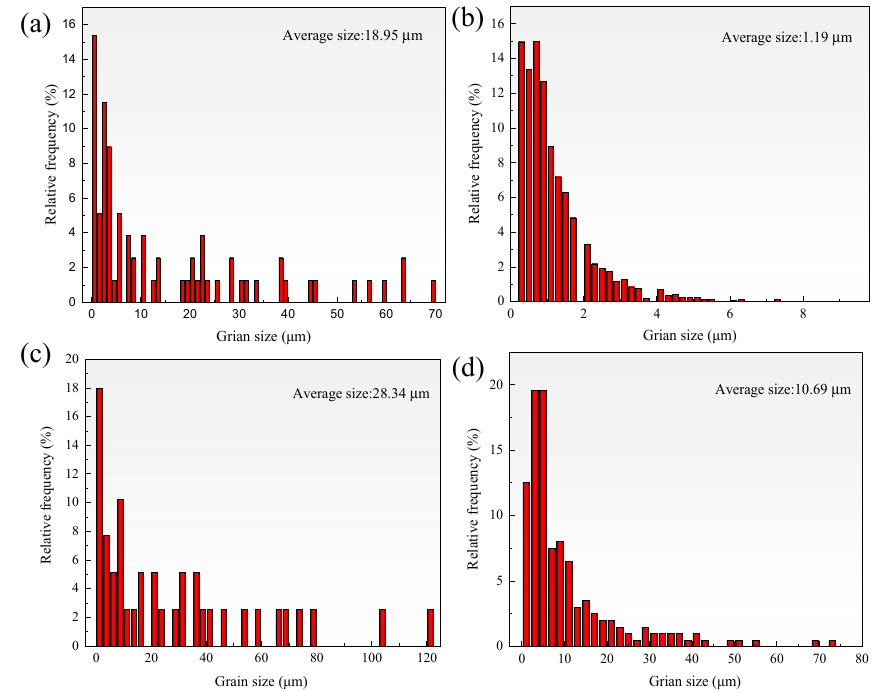
Figure 6. Relative frequency of grains size of annealed 1561 aluminum alloys. ( a ) the H1 plate; ( b ) the H2 plate; ( c ) the N1 plate ; ( d ) the N2 plate.